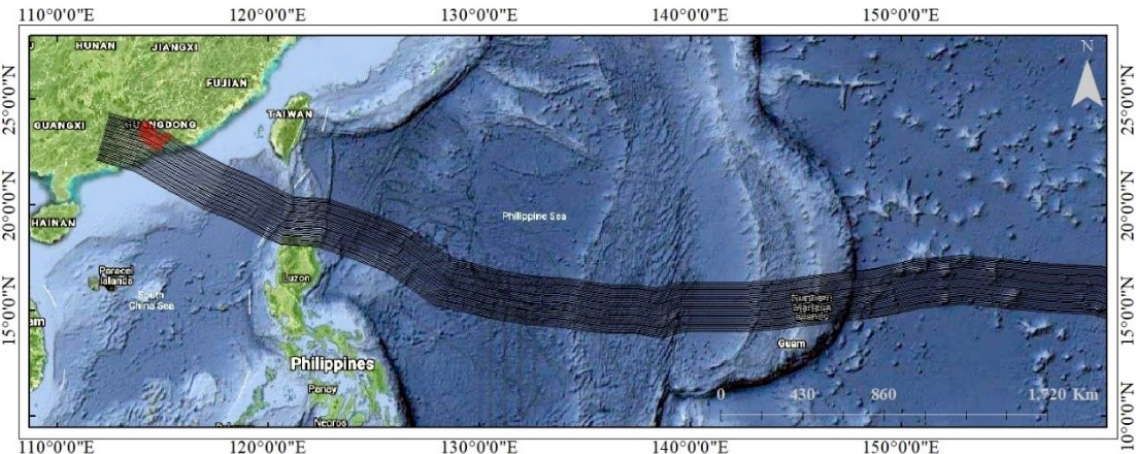
Figure 11. The 34 typhoon tracks (16 shifting to the left and 17 shifting to the right and from the Mangkhut track) over the western North Pacific and the South China Sea. The track map was made using the ArcGIS 10.5 software based on the satellite base map layer, which was obtained from © Google Maps (map data © 2019